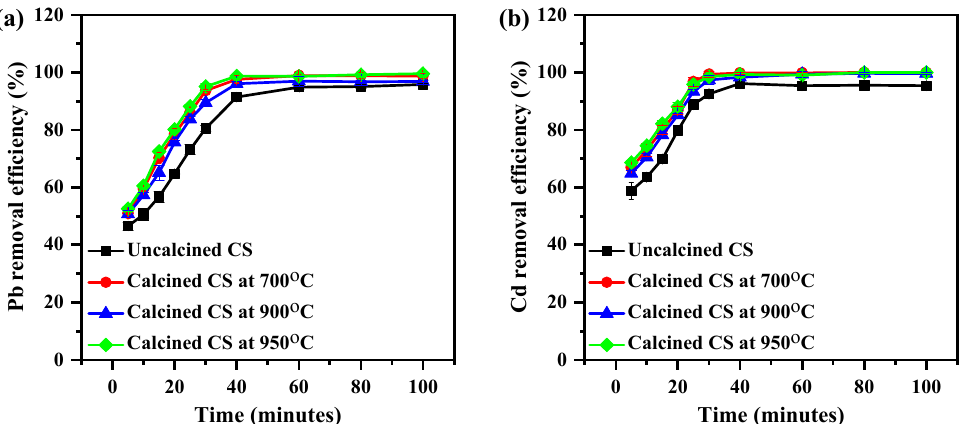
Figure 6. The effect of time on the removal efficiency of ( a ) Pb and ( b ) Cd on CS from aqueous media using the CS at various calcined temperatures (3 ppm of Cd; 1 g of CS, mixture rate of 200